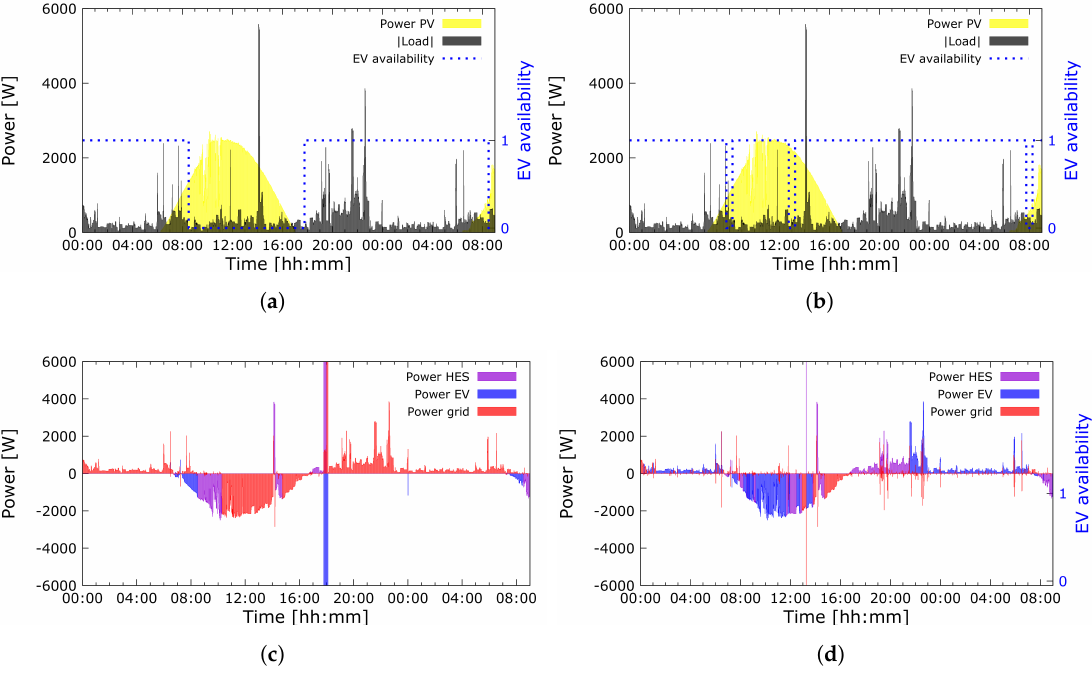
Figure 9. Comparison between primary and secondary EV schedule results. In the top figures the relevant time series are shown, ( a ) shows the primary vehicle, ( b ) shows the secondary vehicle. The bottom figures show the allocated power, ( c ) shows the primary vehicle, ( d ) shows the secondary vehicle. A negative value means the HES or EV is charged, a positive value means the respective component is discharged. In red the balancing power from the grid is shown. A negative value means that power is fed into the grid, a positive values means that power is gained from the